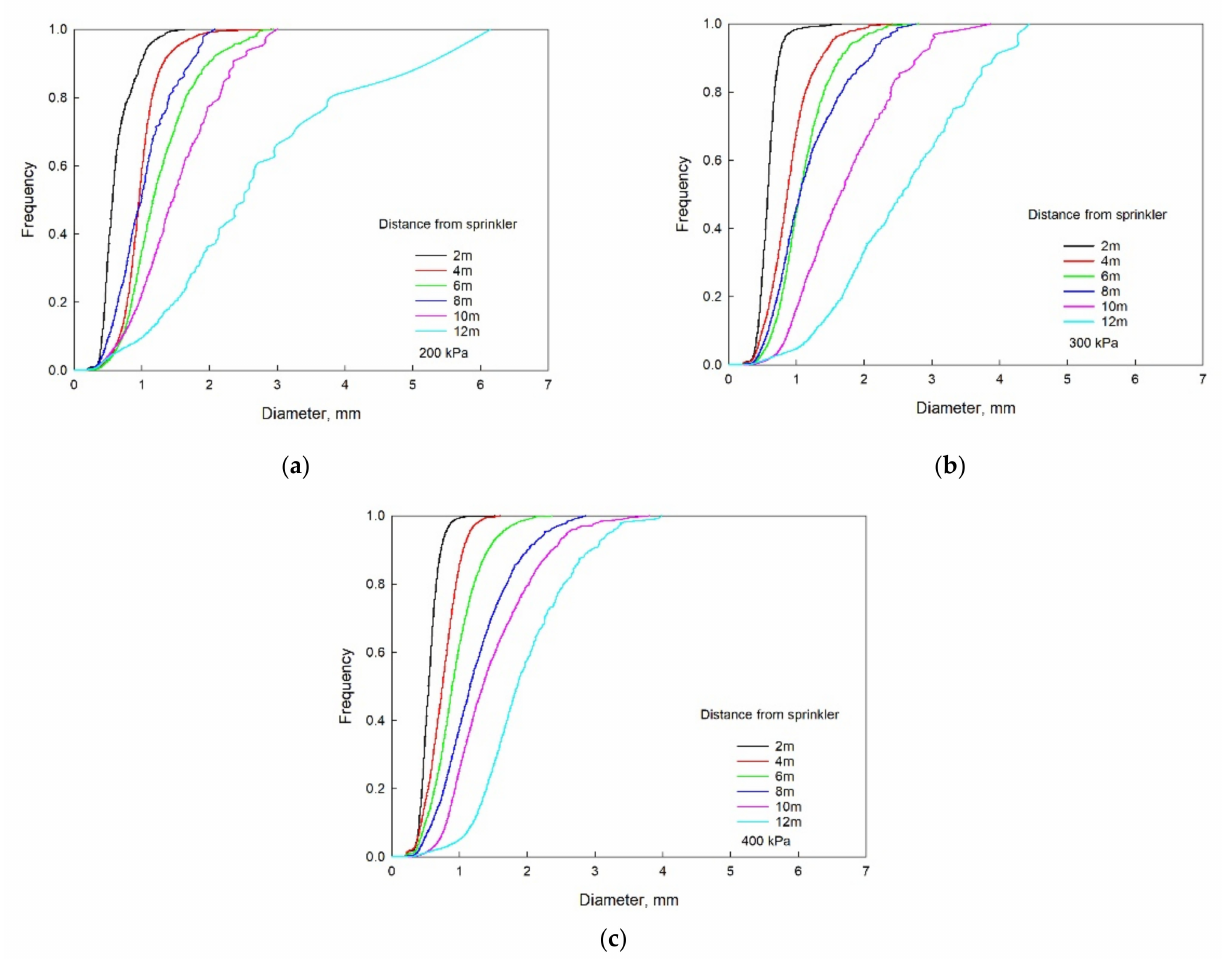
Figure 7. Droplet cumulative volume of the sprinklers with the nozzle sizes of 5.2 mm under